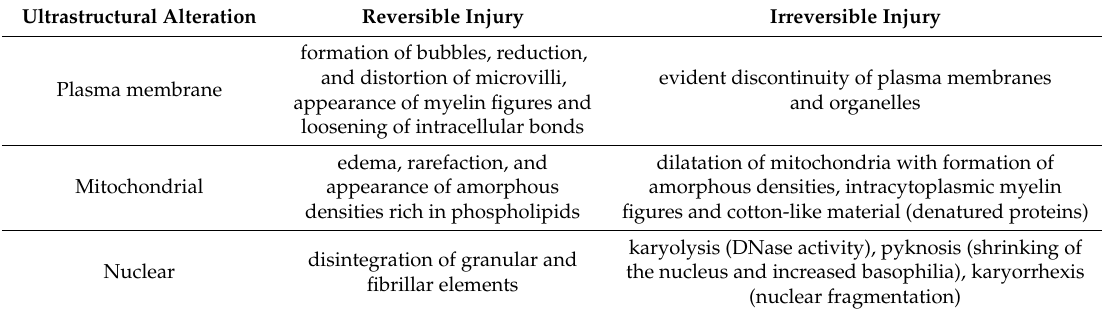
Table 1. Ultrastructural findings regarding reversible and irreversible cell injury (adapted from [9]). Ultrastructural